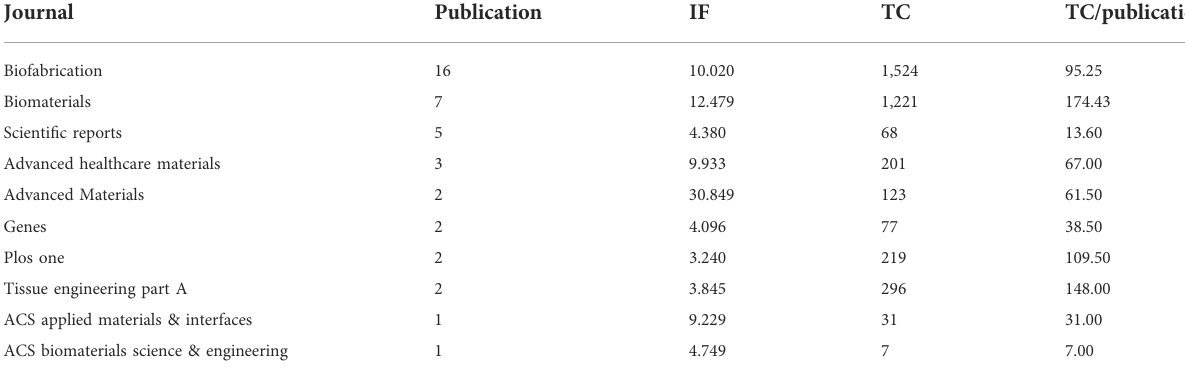
TABLE 2 Top 10 journals with the most